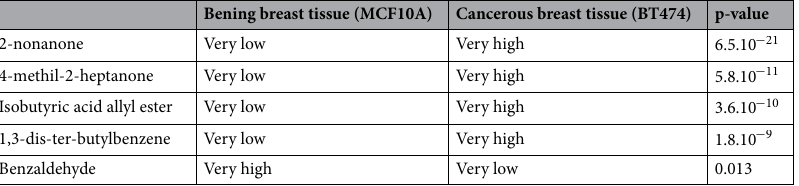
Table 4. Intensity of concentration of various BC biomarkers encountered in cell media: control, benign breast tissue (MCF10A), and cancerous breast tissue